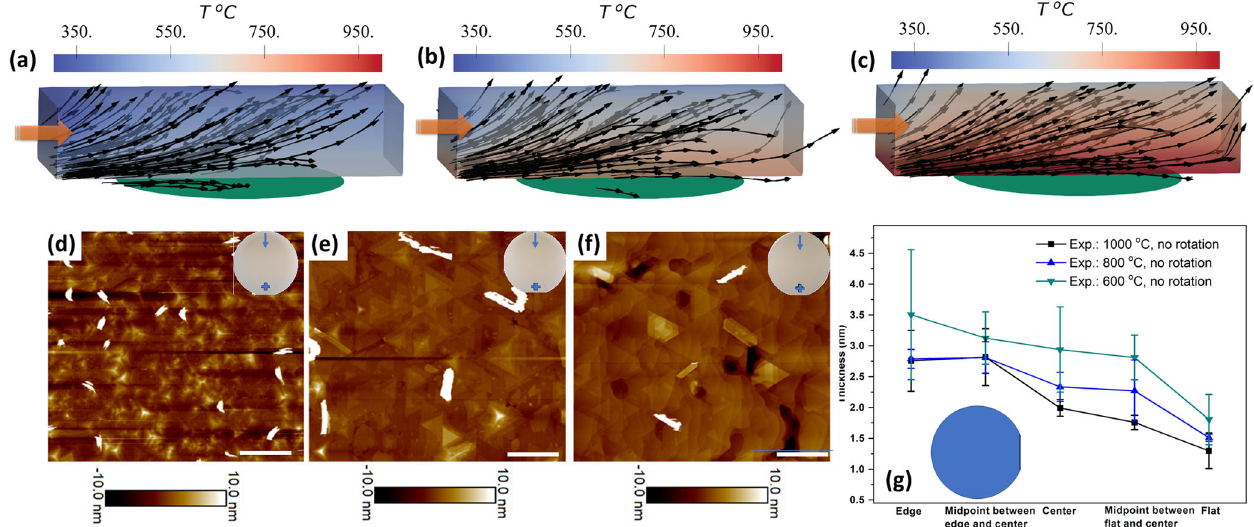
Fig. 2 Effect of growth temperature on growth coverage. Temperature pro fi le and streamlines in the vicinity of the substrate, obtained from CFD simulations, are shown for ( a ) 600 °C, ( b ) 800 °C, and ( c ) 1000 °C substrates. Buoyancy forces dominate upon substrate heating. d – f show the AFM images taken at the positions marked with ‘ + ’ in the inset fi gures of optical microscopy images of WSe 2 fi lms grown on the sapphire substrates at a given growth temperature in ( a – c ). Increased growth temperature leads to larger islands yet lower overall coverages. g Thickness reduces as we move downstream for stationary substrates, as well as upon increasing the growth temperature. Error bars indicate standard deviation of the island thicknesses in each